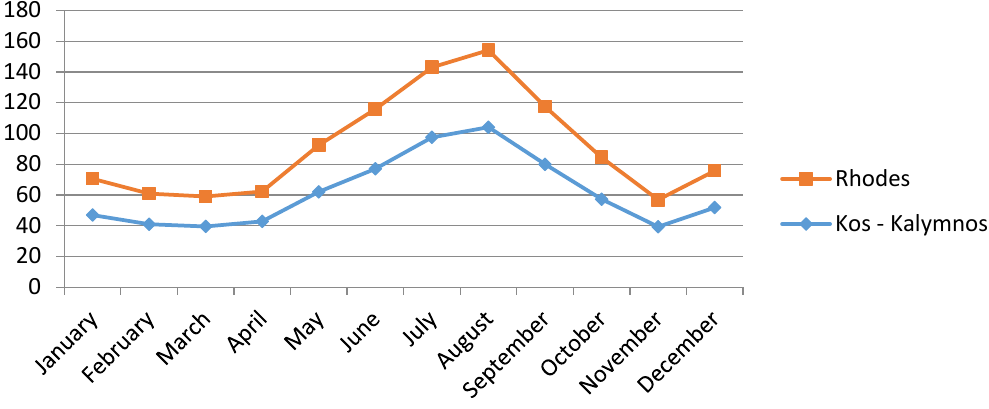
Figure 6. Energy production for the electric energy systems of Rhodes and Kos–Kalymnos, for the year 2013 [51].